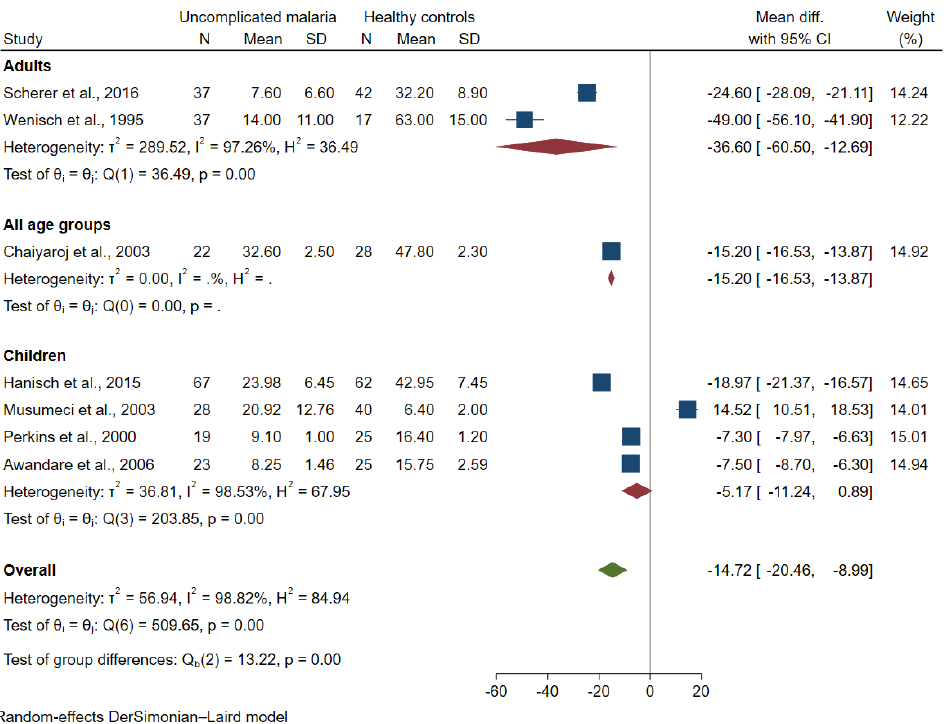
Figure 4. Forest plot demonstrating a difference in mean TGF- β levels (pg/mL) in uncomplicated malaria and healthy controls by age groups [26,27,33,38–40,42]. Grey y -axis line, line of no effect size; blue square boxes, mean TGF- β levels from each study; line on the left and right of blue square boxes, 95% CI; green diamond; overall effect size; crimson diamond, overall effect size in each subgroup; I 2 , H 2 and τ b 2 , heterogeneity